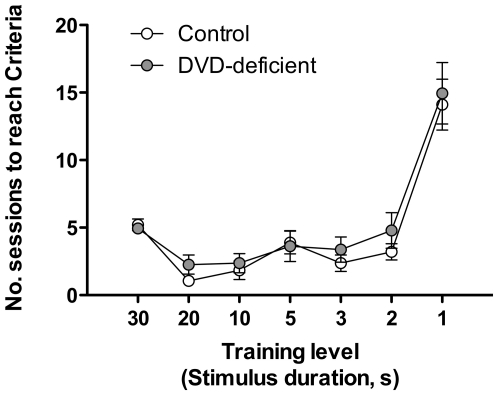
Acquisition of the 5C-SRT.The graphs show the number of sessions (days) to reach criteria for control (n = 19) and DVD-deficient (n = 19) mice on each of the increasingly-challenging training levels (with stimulus duration decreasing from 30 to 1 s). Data are expressed as mean ± SEM.